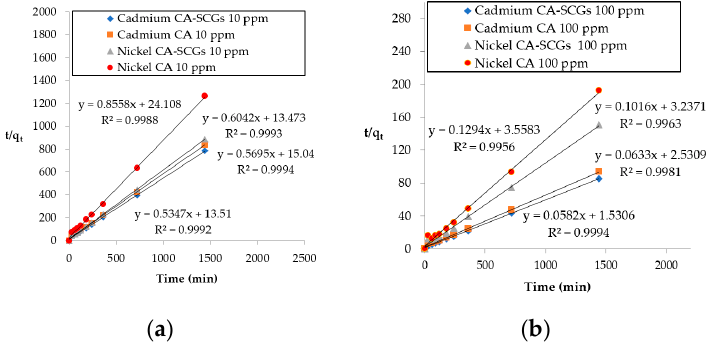
Figure 13. Plots of pseudo-second-order linear equations: ( a ) initial concentration of 10 ppm of metal and ( b ) initial concentration of 100 ppm of metal.